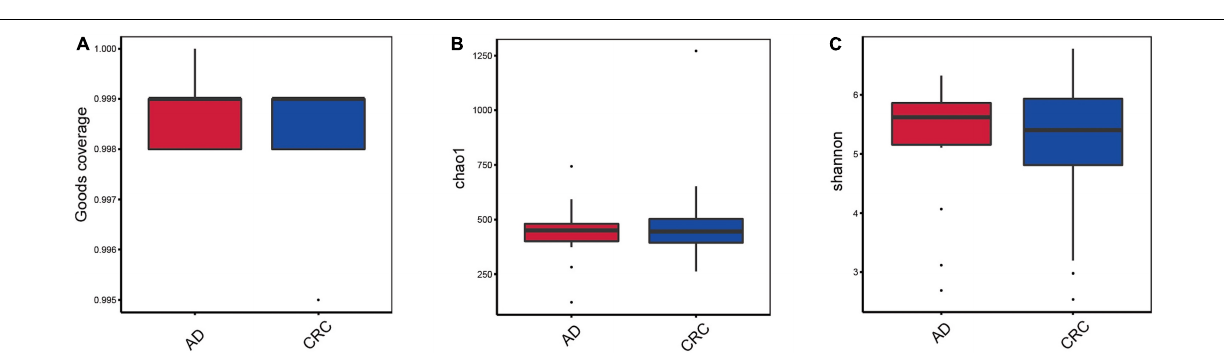
FIGURE 2 | (A) Box plot based on Good’s coverage; (B) Alpha diversity analysis based on the Chao1 index in the AD and CRC group ( P = 0.95); (C) Alpha diversity analysis based on the Shannon index in the AD and CRC group ( P =